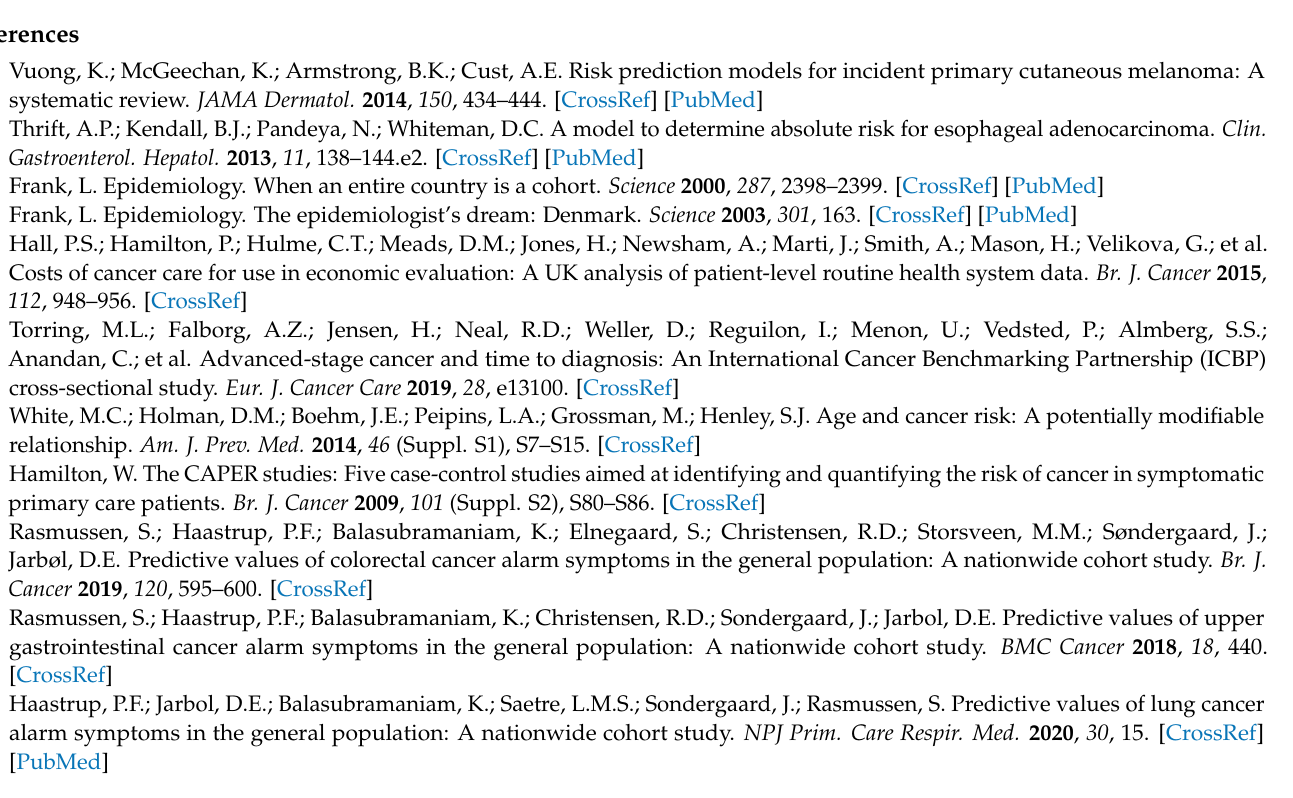
women. Table S4: Model B: Predictive risk factors including socioeconomic data in the development cohort with cancer as outcome for men. Table S5: Diagnostic performance of CRAM prediction models for absolute risk cut-offs of 1% and